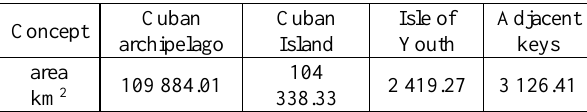
Figure 8. Result of the vector generated over a marsh coastal sector.